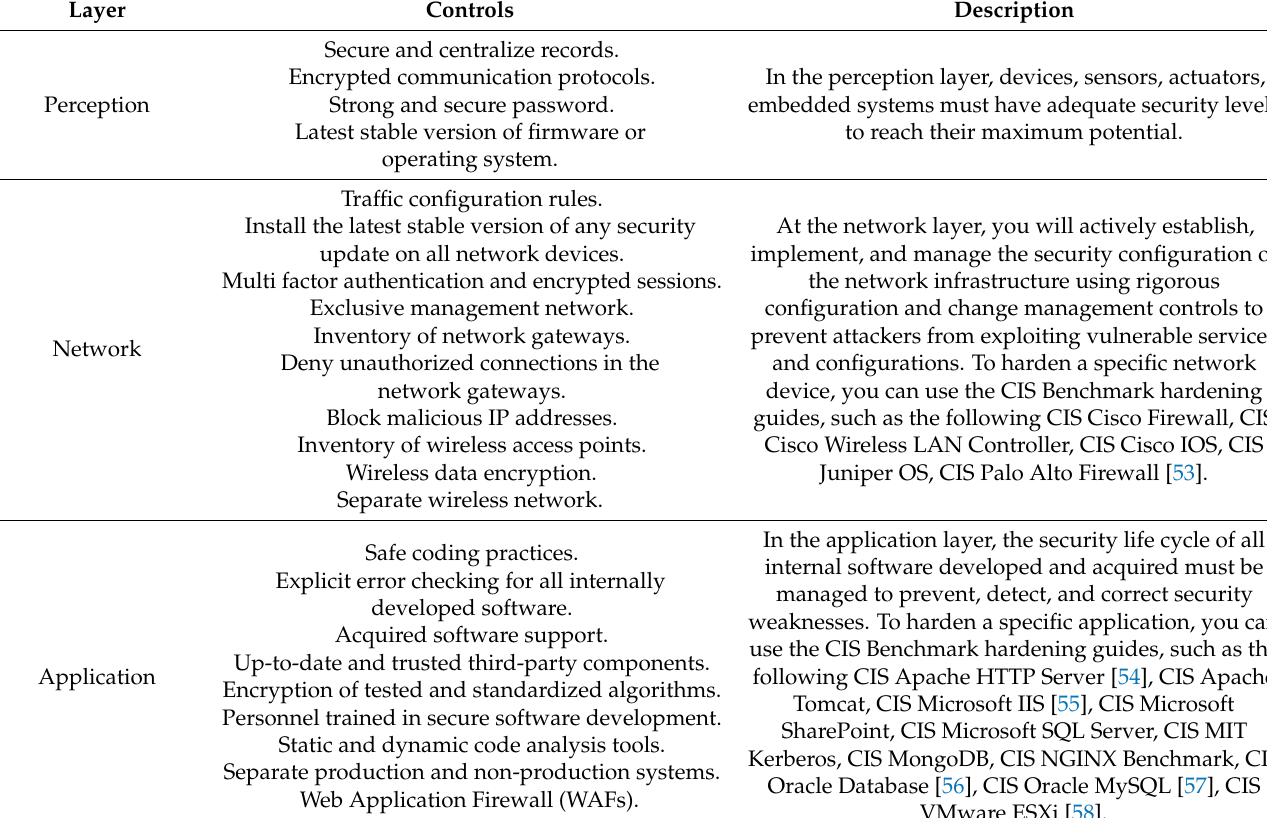
Table 10. Hardening controls in IoT system.